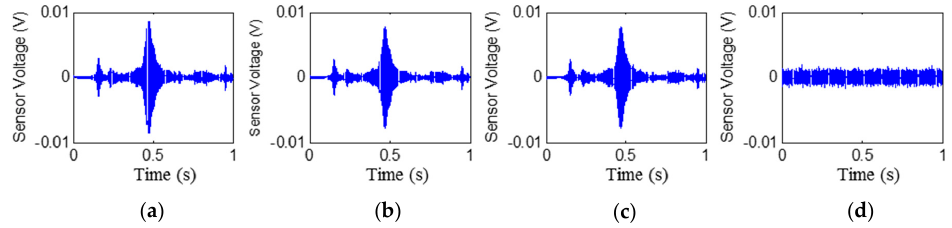
Figure 9. Signal received by PZT 8 (PZT7–PZT8 pair): Stage 0 to Stage 3 from left to the right. ( a ) Stage